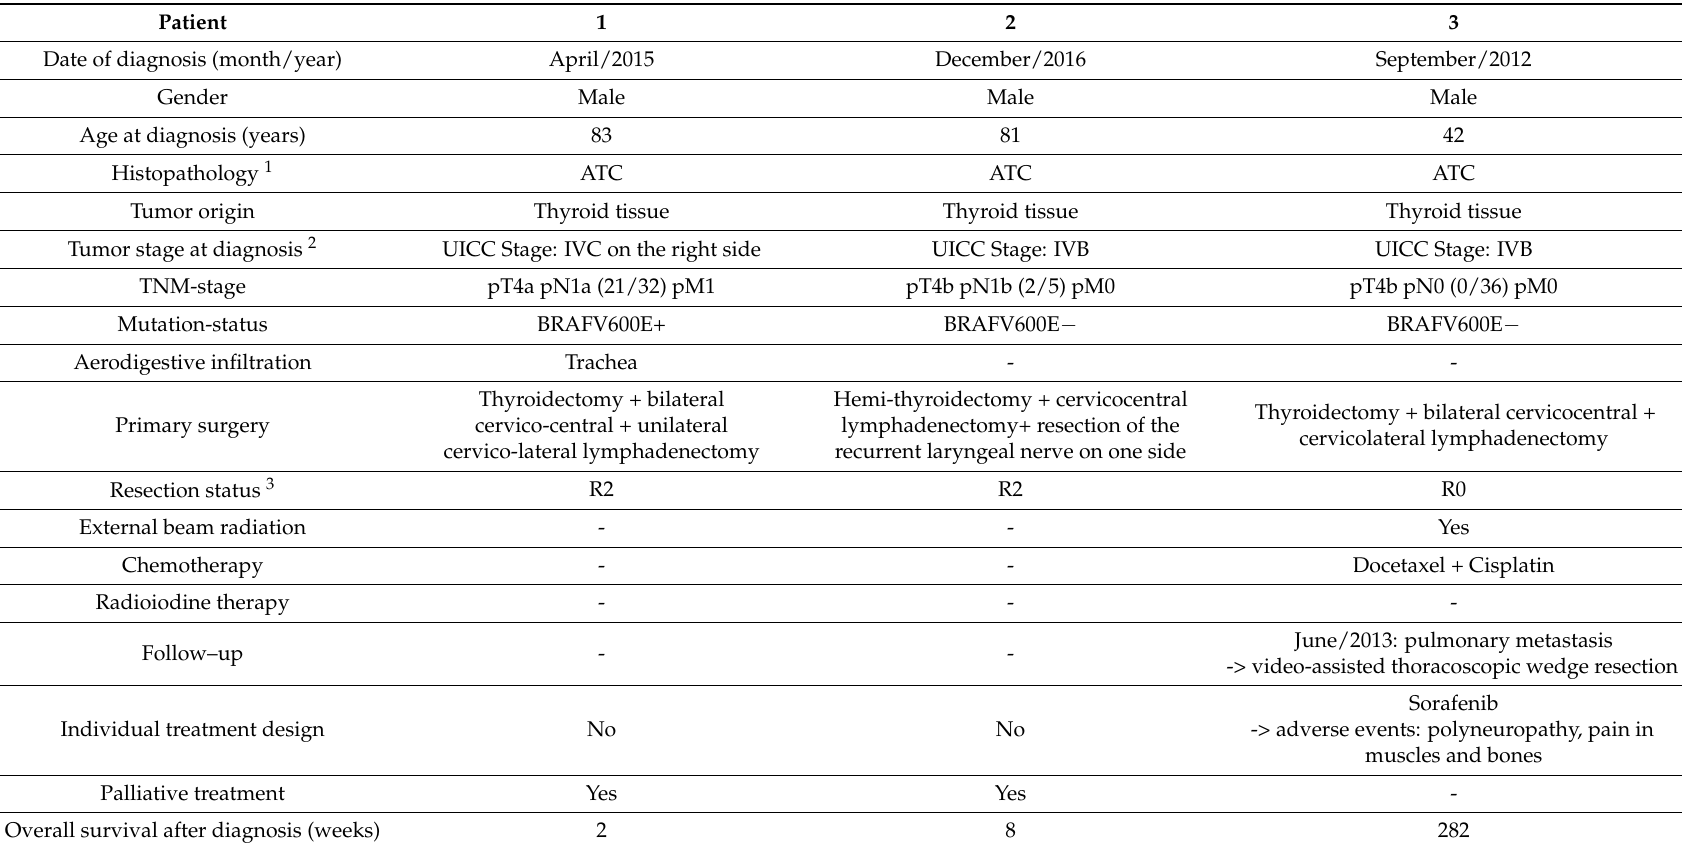
Table 1. ATC patients characterisation based on clinical data collected from tumor board and histopathological